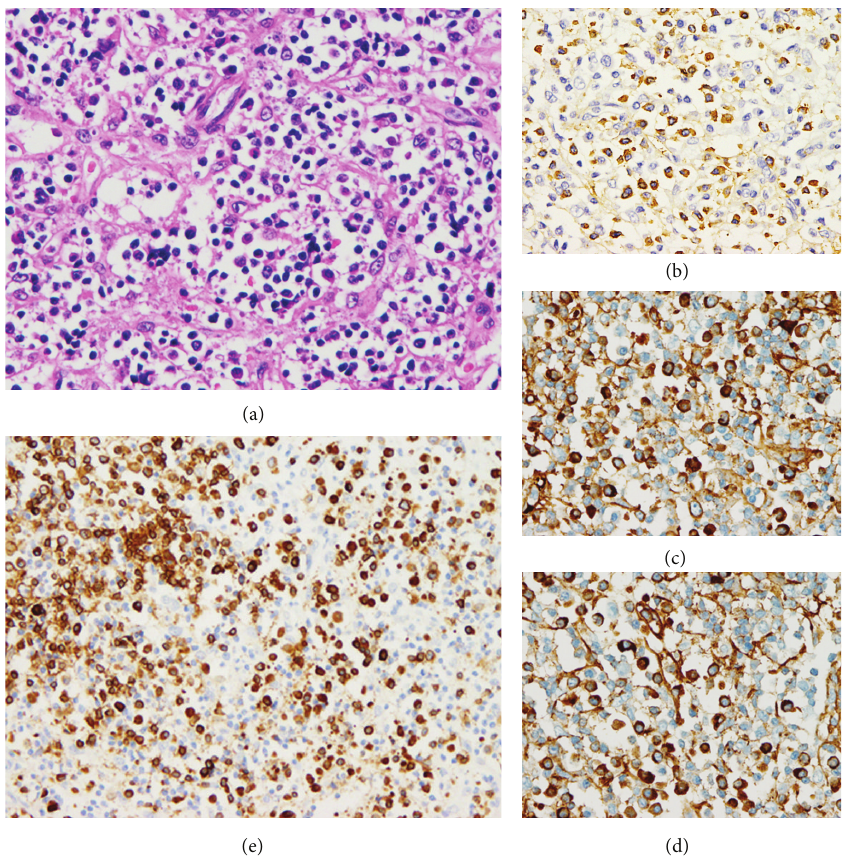
Figure 1: Lymph node biopsy tissue showing numerous plasma cells and fibrotic fibers ((a), HE staining, ×200 ). Immunohistological analysis revealed abundant CD79a-positive B cells ((b), ×200 ) and polyclonal plasma cells secreting kappa and lambda chains ((c) and (d), ×400 ). The existence of large numbers of IgG4-positive plasma cells was confirmed ((e), ×400